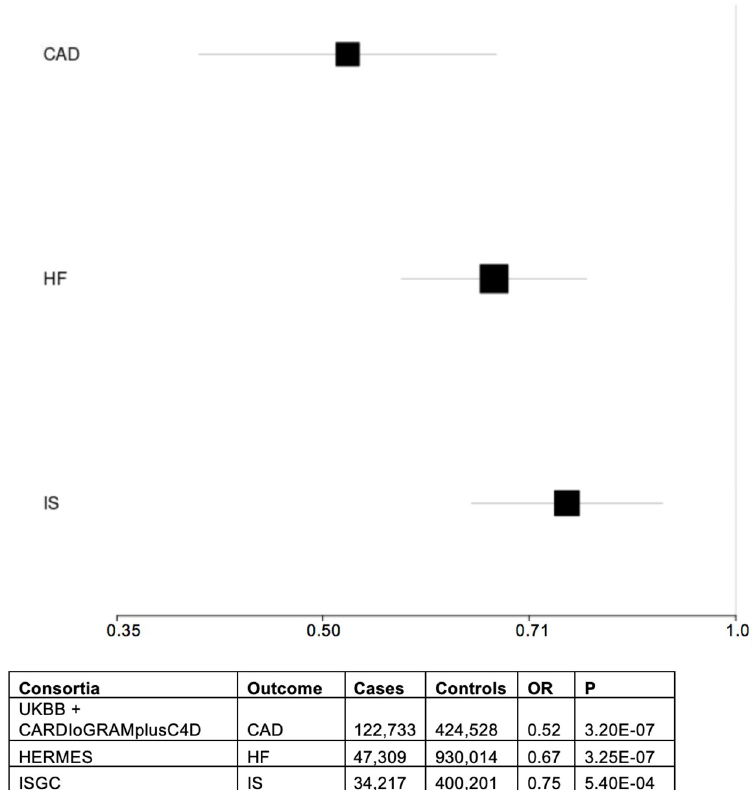
Fig 3. Two-sample Mendelian randomization results & forest plot. The forest plot shows the OR and 95% confidence interval for each CVD outcome (CAD, HF, and IS). The table at the bottom of the figure describes the external consortia used for each outcome, along with the numbers of cases, controls, OR, and p-values. CAD = coronary artery disease; HF = heart failure, IS = ischemic stroke; OR = odds ratio; P = p-value; UKBB = UK Biobank; CARDIoGRAMplusC4D = Coronary Artery Disease Genome-wide Replication and Meta-analysis plus the Coronary Artery Disease consortium; HERMES = Heart Failure Molecular Epidemiology for Therapeutic Targets Consortium; ISGC = International Stroke Genetics